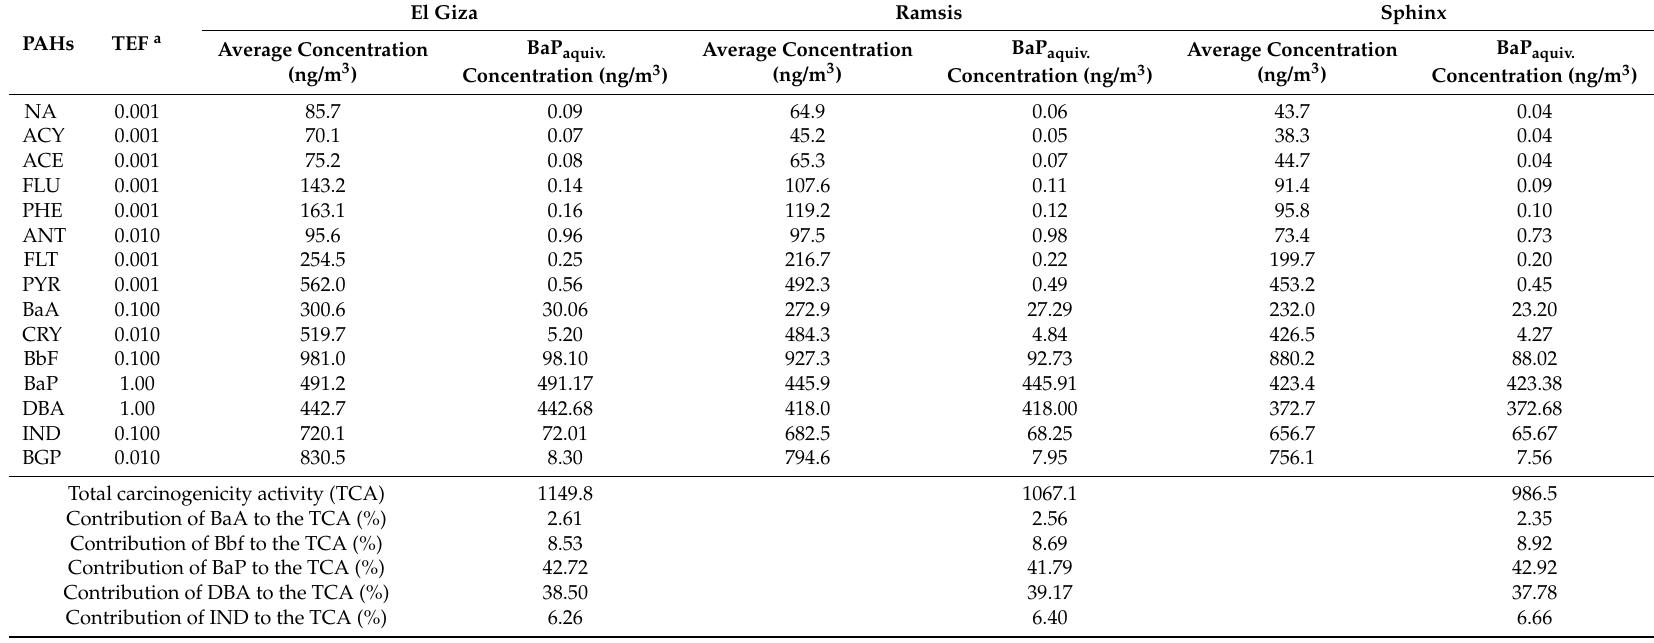
Table 1. BaP equivalent concentrations for particle-bound PAH compounds in the three square areas during the period of